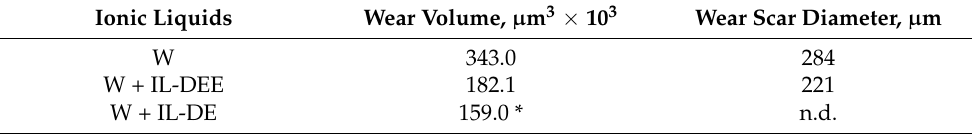
Table 4. Wear volume and wear scar diameter observed in W + IL-DEE tribo-test.